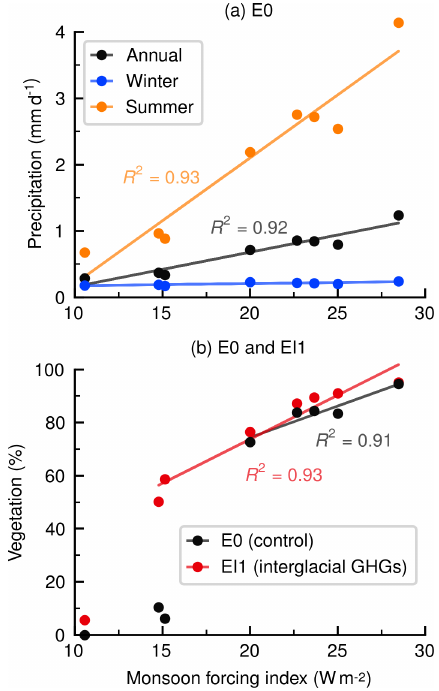
Figure 3. Correlation of the monsoon forcing index with the sim- ulated response in the Sahara grid box in control simulation E0 for mean values of (a) precipitation and (b) vegetation cover fraction during peak times of the monsoon forcing index. Values of E0 are the same as in Table 2. In (b) we also include the modelled vegeta- tion from experiment EI1 with fixed interglacial